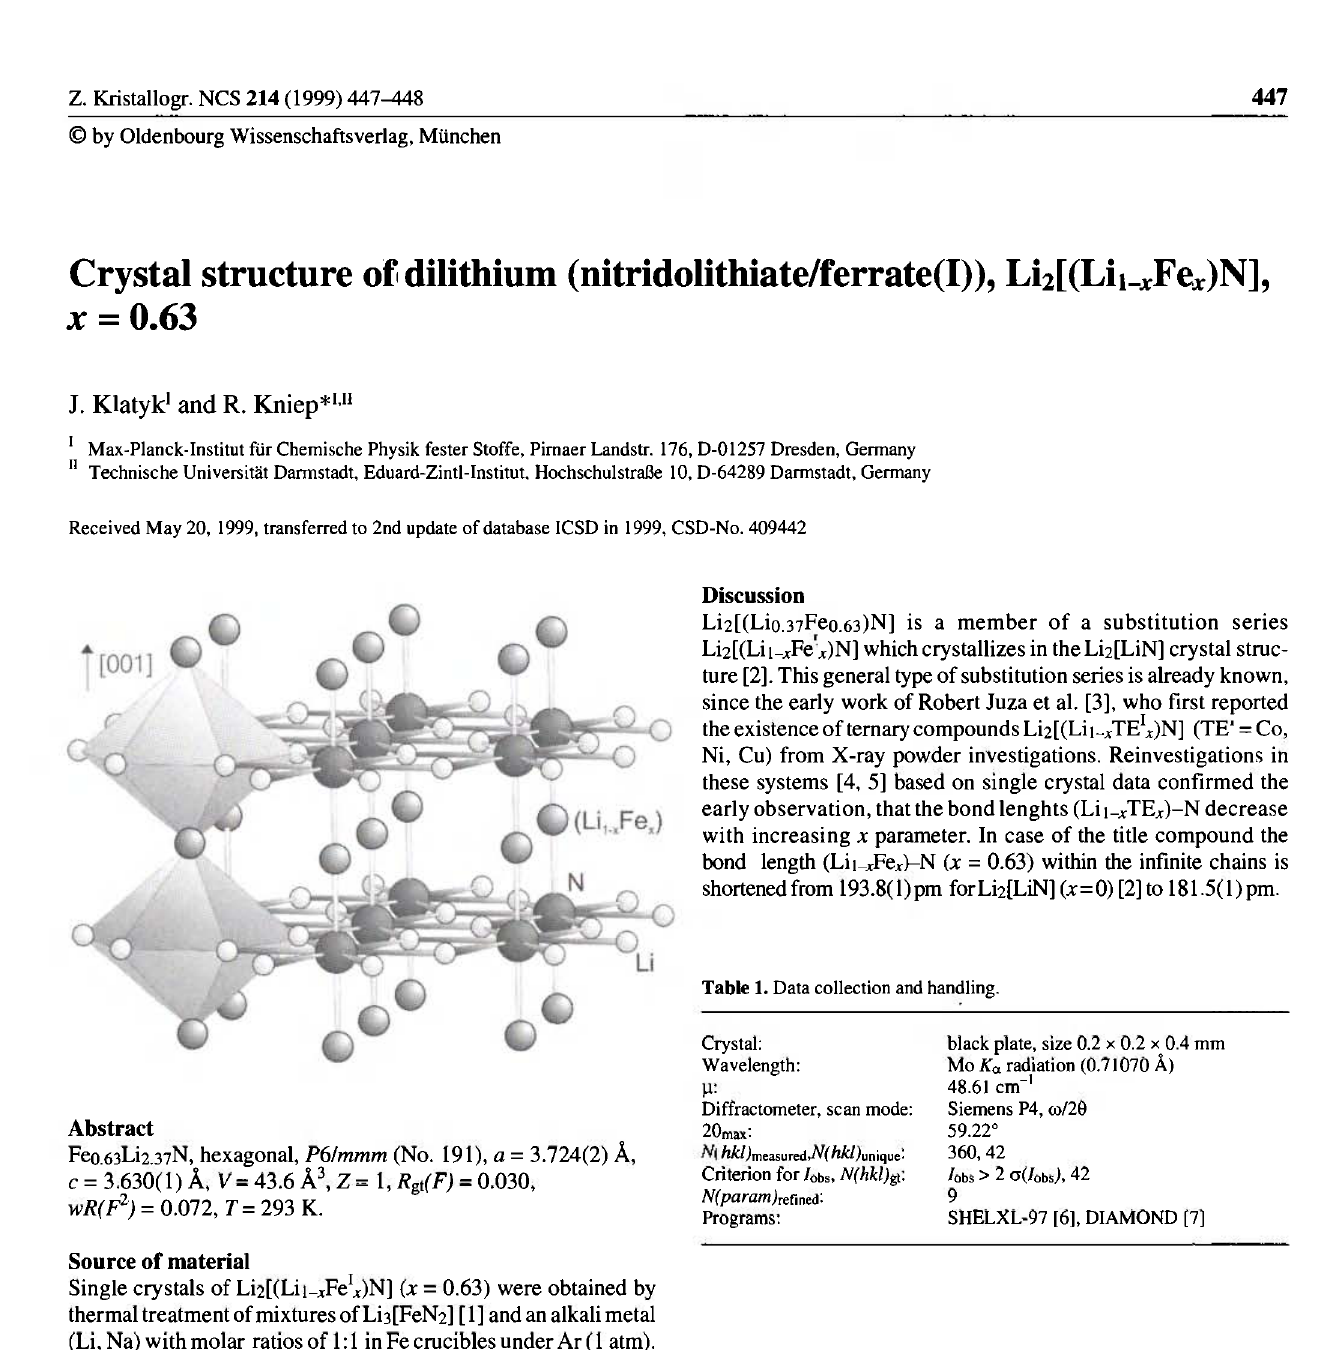
Table 2. Atomic coordinates and displacement parameters (in A 2 ).